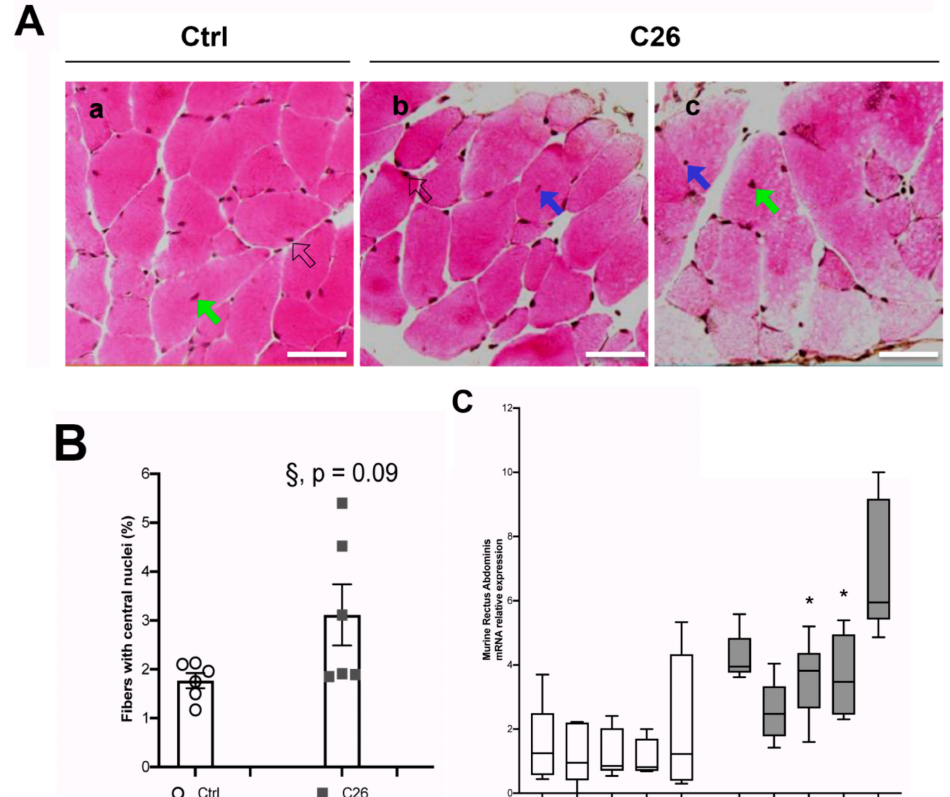
Figure 3. An increased number of central nuclei in the murine Rectus Abdominis (RA) fibers is associated with cachexia and denervation markers. ( A ) Representative images showing H&E staining of cross sections from the RA of control ( a , Ctrl) and C26-tumor bearing (C26) mice; for the latter, two panels from di ff erent regions of the muscle are shown ( b and c ). Central nuclei are indicated by blue or green arrows (in the first case the nucleus is just displaced from its subsarcolemmal position, while in the second case it is closer to the center of the fiber); peripheral (i.e. normal) myonuclei are indicated by open arrows. Scale bar is 50 µ m. ( B ) Percentage of fibers with central nuclei in control (Ctrl) and C26 mice. The Student’s t test showed a quasi-significant di ff erence (§, p = 0.09) between Ctrl and C26. ( C ) Q-PCR analysis on muscle from the RA of Ctrl and C26 mice for denervation markers as indicated. Data are presented as box-and-whisker plot, showing the median +/ - 10–90 percentile range, and analyzed by using Wilcoxon-Mann-Whitney test; * p < 0.05; n = 6 for each